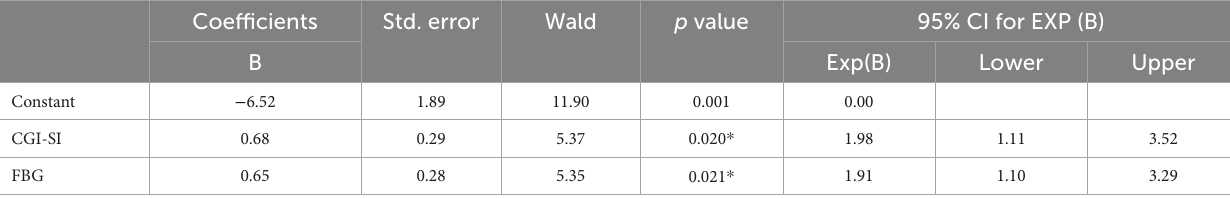
TABLE 2 Factors influencing early non-response in all included patients: a binary logistic regression model.